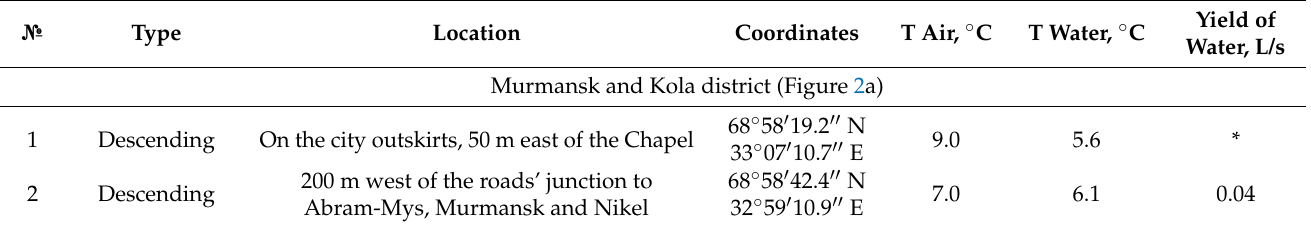
Table 2. Coordinates, type and location of the investigated springs, air and water temperature, pH and flow rate at the time of sampling.